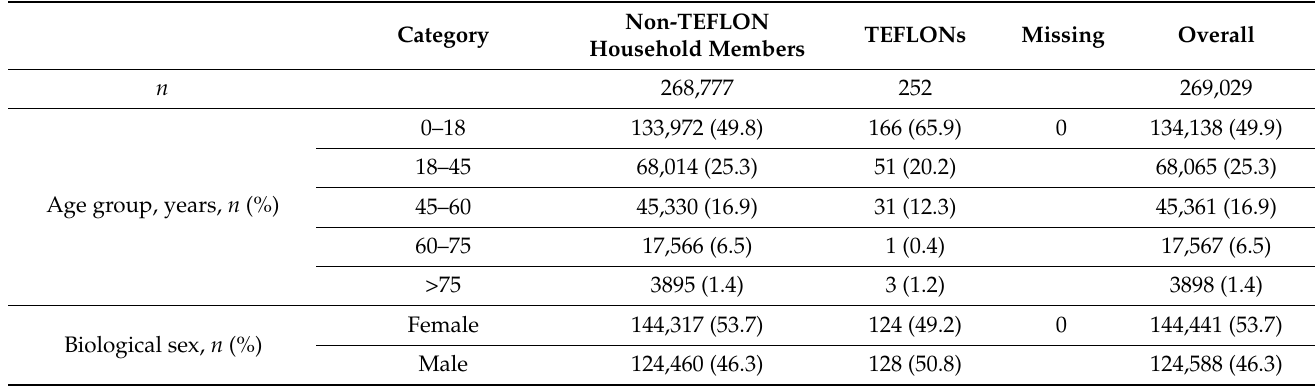
Table 1. Characteristics and exposing agents of the individuals included, by group: TEFLONs (Timely Exposed to Family members Leaving One Not infected) and non-TEFLON household mem- bers.